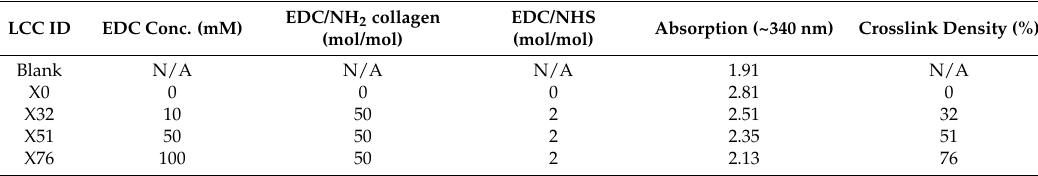
Liquid crystalline collagen (LCC) crosslink density as a function of N , N -(3-dimethylaminopropyl)- N (cid:48) -ethyl-carbodiimide hydrochloride (EDC) concentration (n = 1 due to limited sample